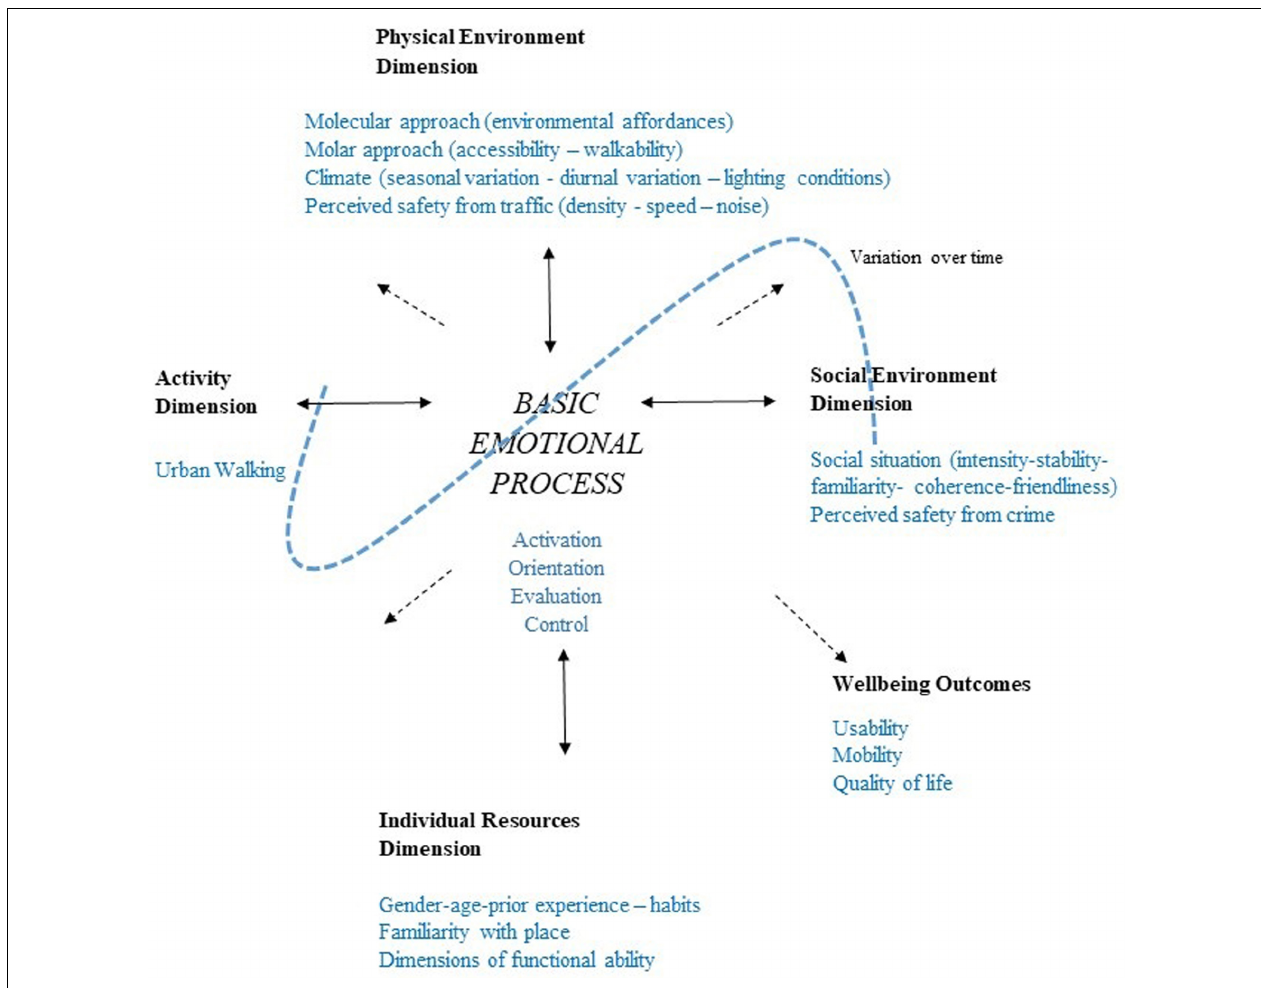
FIGURE 1 | Operationalization of the HEI model for investigating urban walking among people with